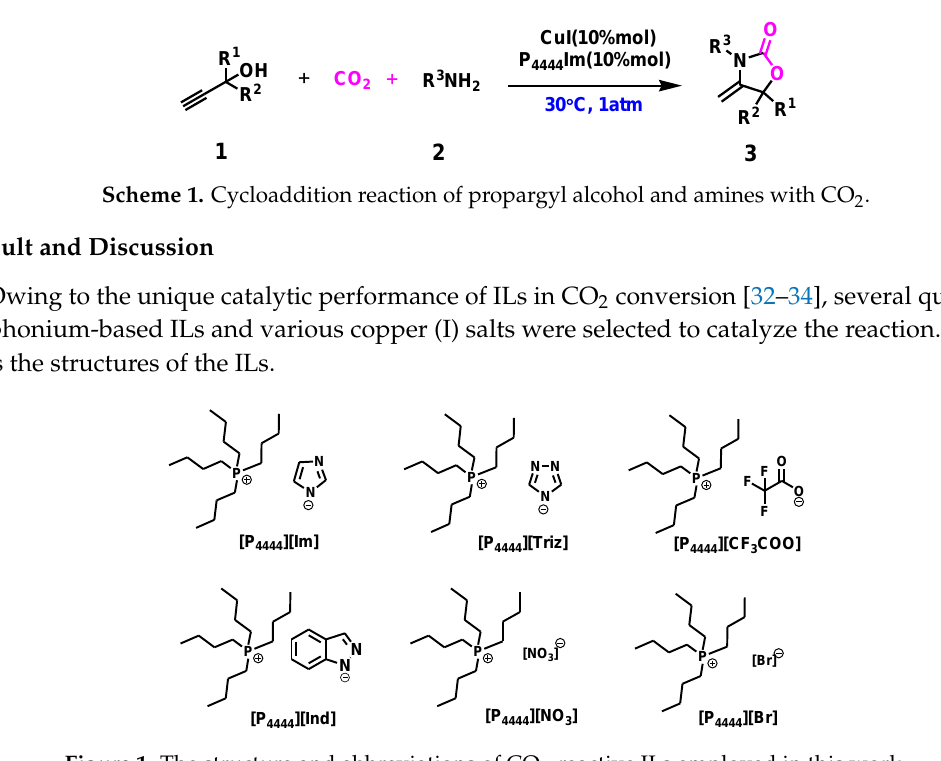
Figure 1. The structure and abbreviations of CO 2 -reactive ILs employed in this work.